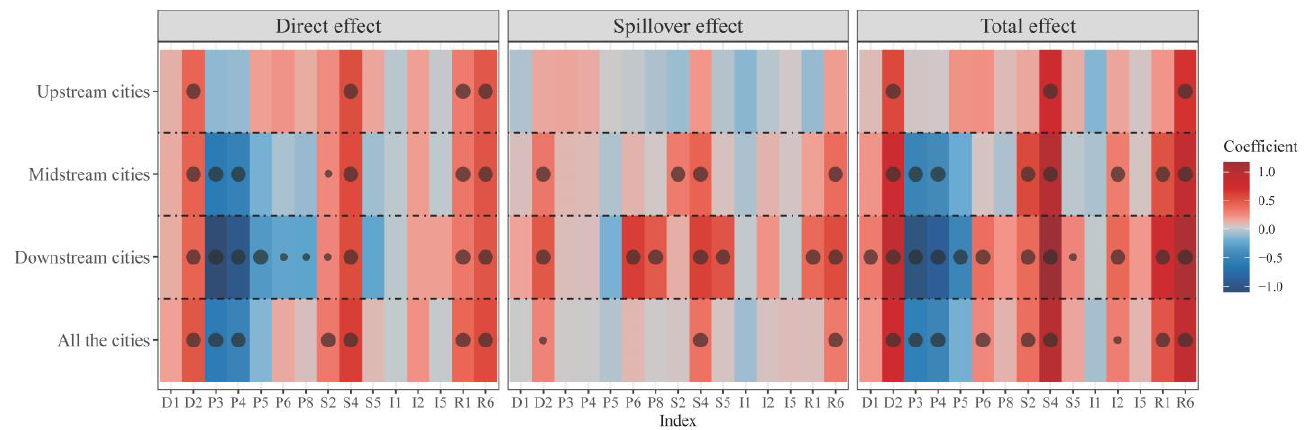
Figure 6. Spatial effect decomposition of the tourism eco-security index of the Yellow River basin. The large and small dots in the figure indicate the significance levels of 0.01 and 0.05, respectively. From different regions of the Yellow River basin, there are large differences between regions, and the number of influencing factors tends to decrease from the lower to the upper regions of the basin, which may be related to each region’s economic development level. The spatial spillover effect is not even significant in the upper reaches, which indi- cates that there is still much room to improve tourism eco-security in the upper reaches. Some indexes have reached significant effects in the Driver, State, and Response levels in the middle reaches. In particular, the vegetation index had a significant effect only in the middle reaches, which indicates that the effectiveness of afforestation in this region con- tributes significantly more to the spatial evolution pattern of tourism eco-security than in the upper and lower reaches. It also reflects the significant positive effect of afforestation on the ecological environment and related areas. Compared with the middle and upper reaches, the most significant influence indexes were found in the lower reaches, which indicates that a better system of tourism eco-security has been formed in the lower reaches, which may be the reason for the rapid expansion of hotspots in the lower reaches compared to the middle and upper reaches. In the coming period, the tourism eco-security level in the lower reaches of the Yellow River basin is likely to expand from the provincial capital cities to the nearby prefecture-level cities much faster than in the middle and upper reaches. Therefore, when focusing on planning and managing tourism eco-security in in- dividual areas of the Yellow River basin, both the whole basin’s and the local situation should be taken into account. Especially in the lower reaches of the Yellow River, we should regard D2, S4, and R6 as the key factors of the whole basin. Additionally, we should also consider the magnitude of the influence of other factors such as P3, P4, S2, and R1. This complicated and systemic approach makes it more difficult for planners to plan the area. The ecological environment of the Yellow River basin is extremely fragile due to its unreasonable historical development, and the environmental carrying capacity of many regions is unable to meet the impact of tourism activities. Especially in recent years, the demand for tourism has increased rapidly. Through the measurement of the Yellow River basin tourism ecological security, this study provides a reference for the country and peo- ple of the Yellow River basin tourism ecological security temporal – spatial status quo and change trends. From the national level, although tourism ecological security in the Yellow River basin has shown a rising trend in recent decades, its overall level is still very low and not optimistic. Therefore, more emphasis should be placed on the protection of the ecological environment in the formulation of tourism development planning of the Yellow River basin, adhere to local conditions, fully consider the differences between big and small cities and different river basins, establish a cross-regional coordination mechanism for tourism ecological compensation, and effectively promote the development of tourism